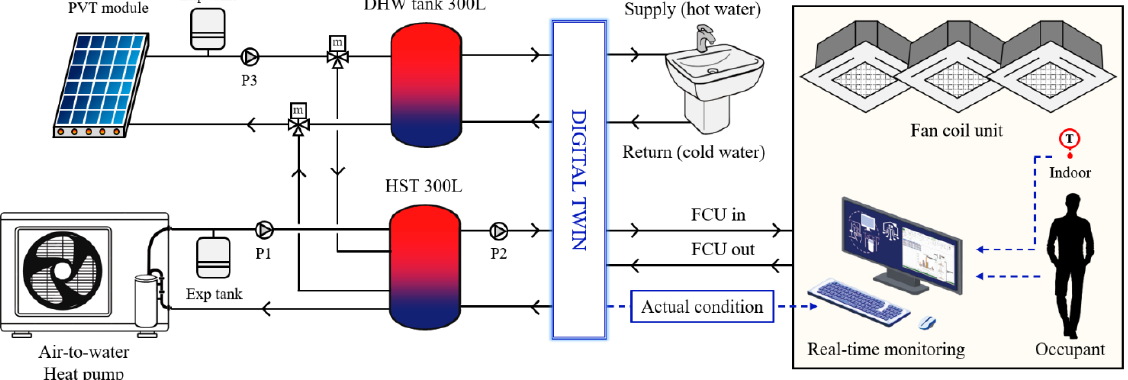
Figure 1. Schematic of the integrated system with photovoltaic-thermal and air source heat pump.